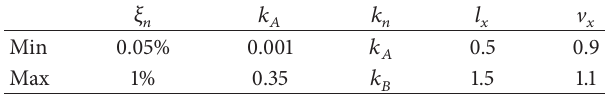
Table5:BoundsfortheMonteCarlosimulationsfor V ̸= 1 and 𝑙 ̸= 1